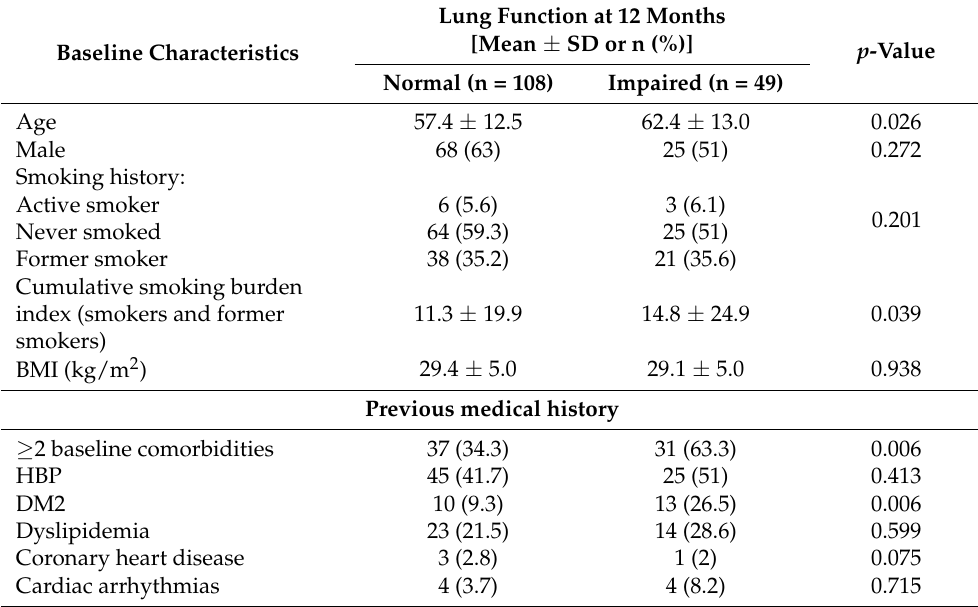
Table 1. Baseline comorbidities, demographics, clinical and physical characteristics of the patients at admission, during hospitalization and at the 12-month follow-up